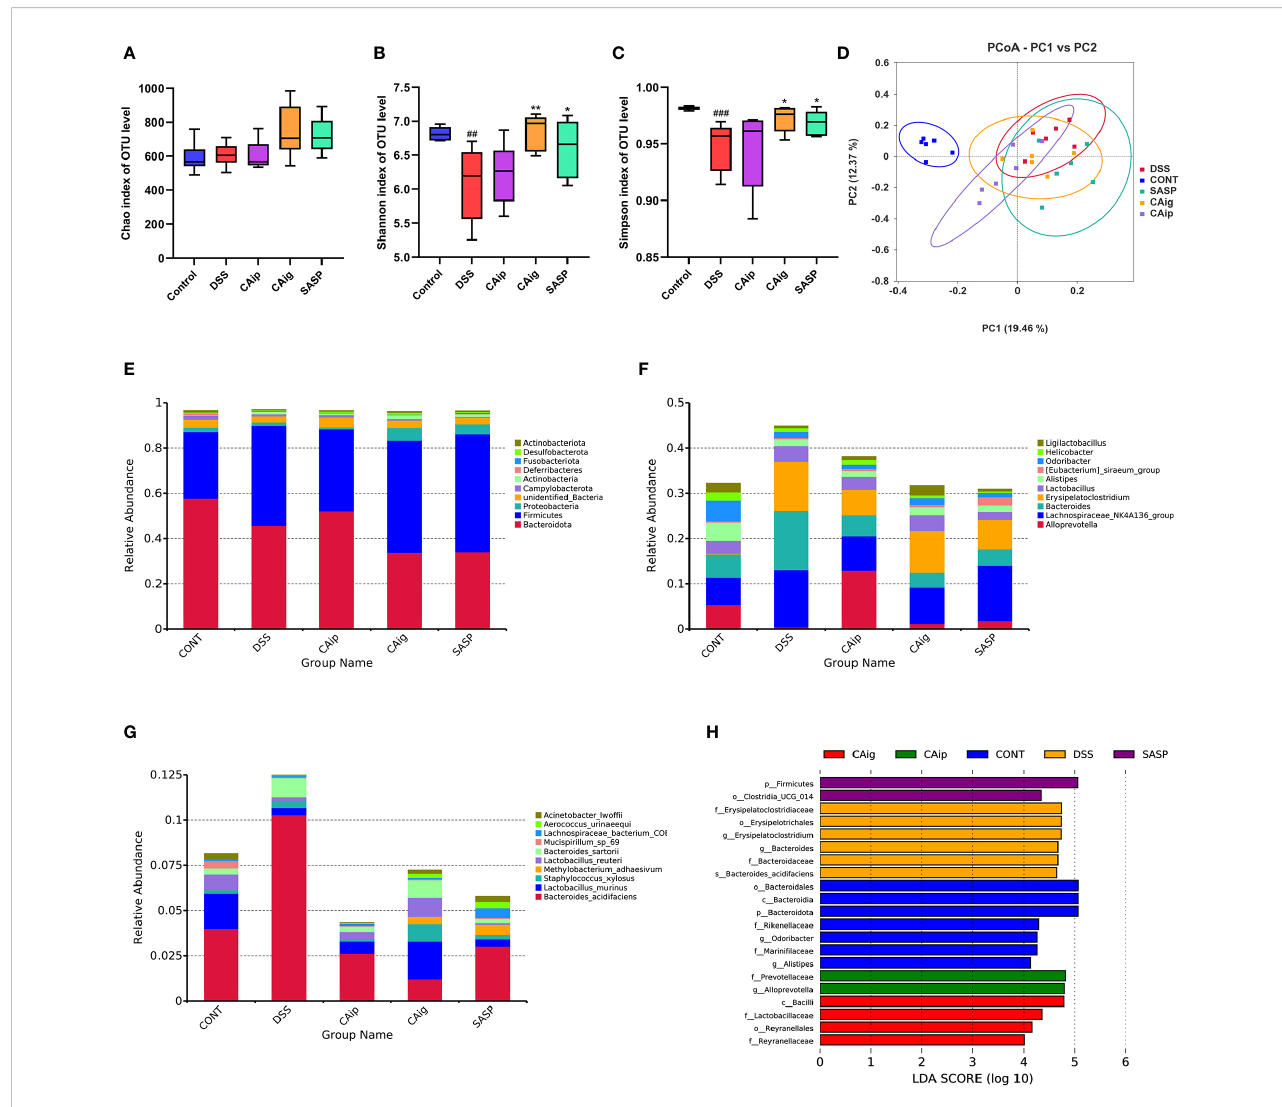
FIGURE 5 CA treatment altered the gut microbiota diversity and composition. Alpha diversity estimated by the Chao (A) , Shannon (B) and Simpson (C) indices of OTU level. (D) Principal coordinate analysis (PCoA) using Bray-Curtis metric distances of beta diversity. The relative abundance of fecal microbiota in the top 10 of phylum (E) , genus (F) and species (G) levels. (H) The LEfSe analysis. The criterion is log LDA score > 4.0. n = 6 for each group. ## P < 0.01, ### P < 0.001 vs. Control group, * P < 0.05, ** P < 0.01 vs. DSS